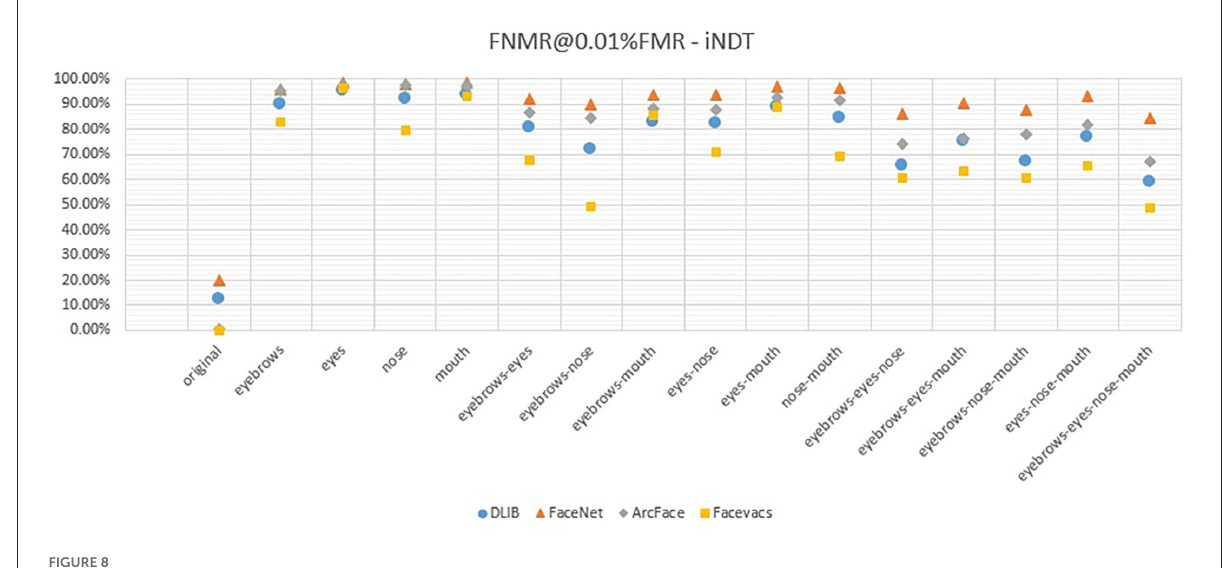
FIGURE8 The behavior of iNDT on four deep face recognition systems.